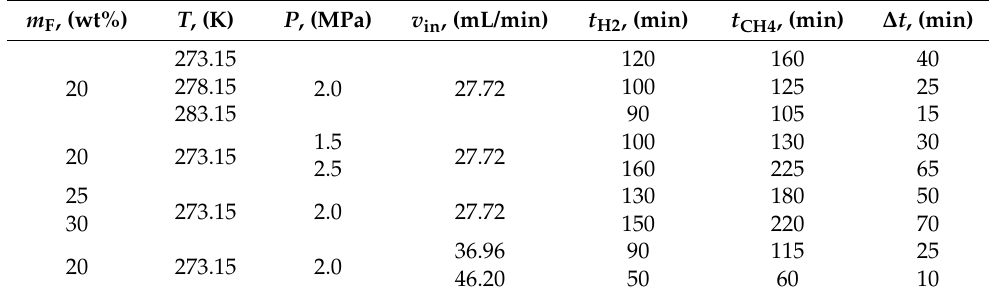
Figure 4. Breakthrough experimental results of CH 4 /H 2 (34.22/65.78 mol%) mixture separation in a slurry of ZIF-8 20 wt% + ethylene glycol 16 wt% + water 64 wt% at the inlet gas flow rate of 27.72 mL/min, as well as conditions: 2.0 MPa, different temperatures of 283.15 K, 278.15 K, and 273.15 K. (The solid curve in the figure is H 2 and the hollow curve is CH 4 ). Table 2. Comparison of the breakthrough time of CH 4 and H 2 and their difference under different experimental